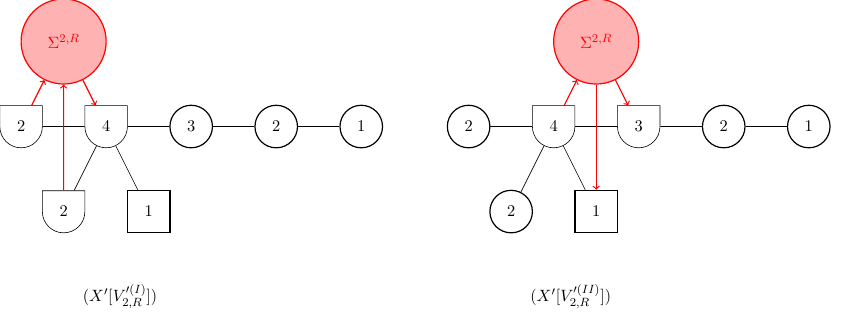
Figure 38 . The construction of a vortex defect in the bifurcated quiver gauge theory X 0 , labelled by a representation R of the gauge node U(4) . It is dual to a Wilson defect in the theory Y 0 (an Sp(2) gauge theory with N = 6 ), labelled by a representation e R of Sp(2) , where e R is the restriction of the f representation R for Sp(2) ⊂ U(4) . The S -type operation O is a non-Abelian gauging operation. P